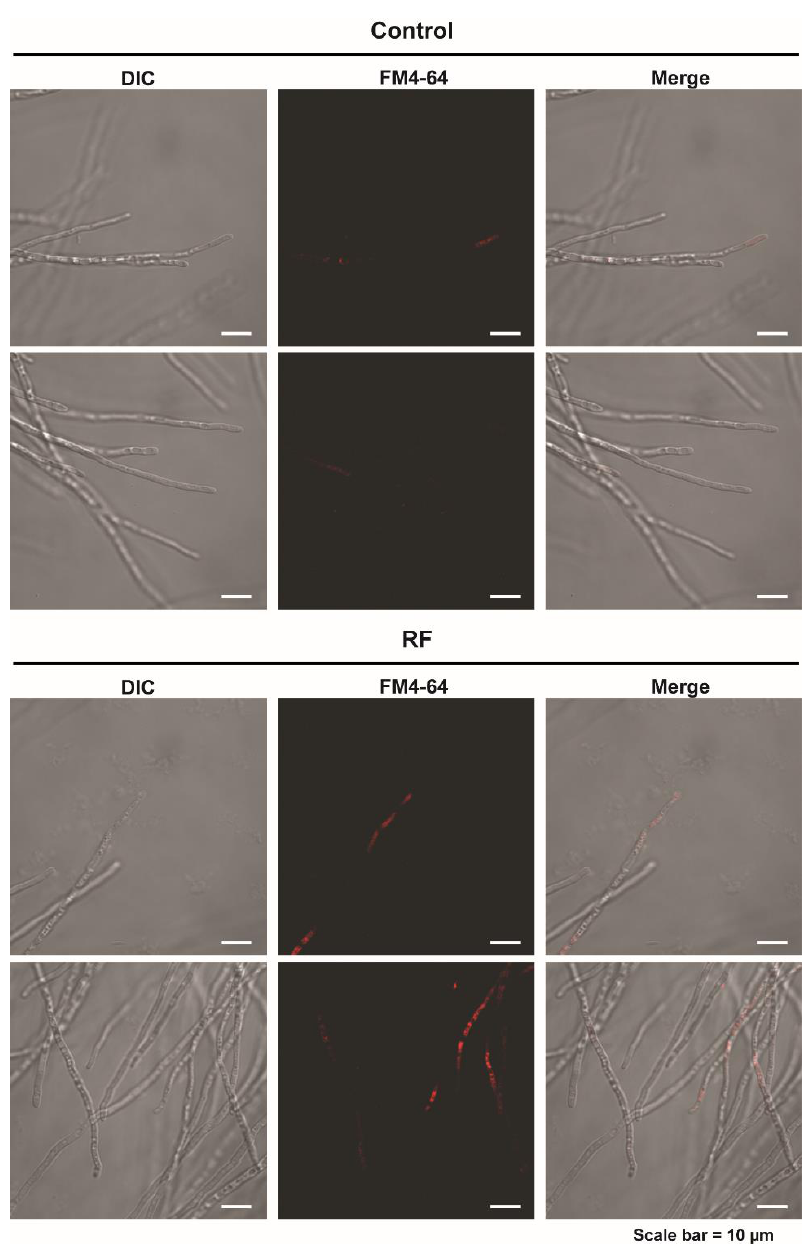
Figure 4. Staining of vesicles using FM4-64 in fungal hyphae at 16 h after fungal spores were un- exposed (control) and exposed to RF-EMF (2 GHz, 0.01 W) for 10 min. We also observed that transcription of some genes involved in regulating cellular trafficking of secretory proteins was significantly increased after exposure to RF-EMF (Figure 5).